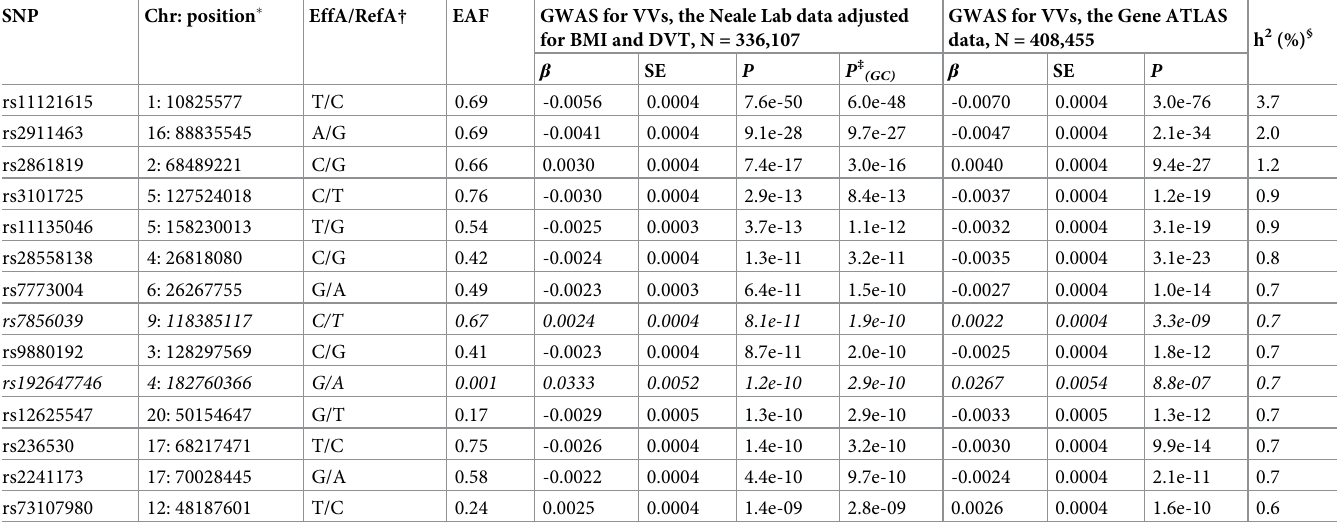
Table 1. Top SNPs associated with varicose veins of lower